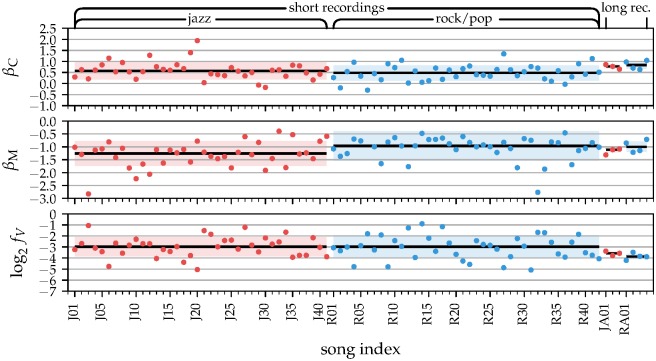
Fit parameters of the unpaced musical recordings by genre (jazz: red, rock/pop: blue).Both, the music performances and our studio recordings showed consistent tendencies (median (SD) given as black lines (colored ranges) for the individual parameters). Most prominently, the motor persistence βM is genre-dependent.